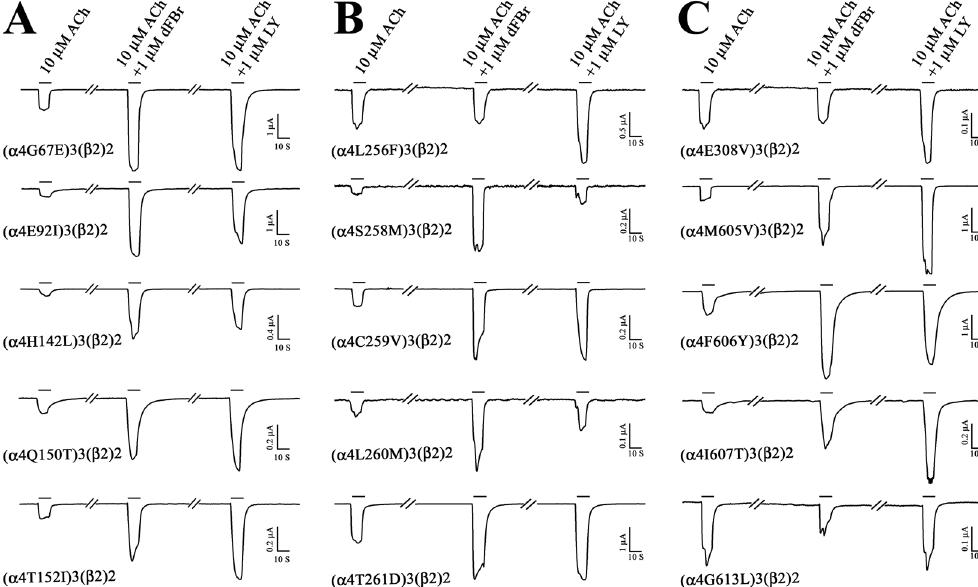
Figure 5. Effect of Amino acid substitutions within α 4 extracellular and transmembrane domains on LY2087101 and dFBr potentiation of ( α 4)3( β 2)2 nAChR. Representative two-electrode voltage clamp traces showing the effect of 1 μ M LY2087101 or 1 μ M dFBr on ACh-induced current responses of Xenopus oocytes expressing ( α 4)3( β 2)2 nAChRs containing an amino acid substitution at the α 4 subunit extracellular domain ( A ) or within the α 4 subunit transmembrane domain ( B and C